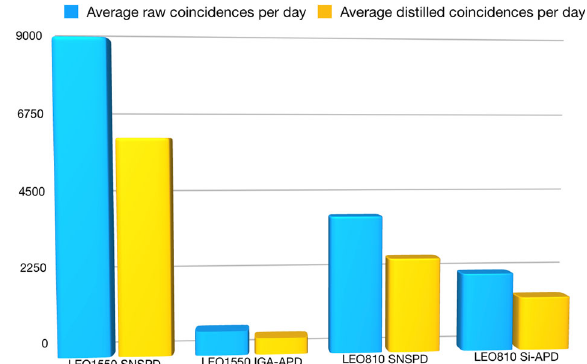
Fig. 7 Mean raw (blue bars) and distilled coincidences per day (orange) as reported in Table 3. Shown are results for the LEO with inclination 50 degrees and height 600 km, and a wavelength of 810 nm and 1550 nm with Avalanche Photo Detectors (Si-APD @ 810 nm, InGaAs-APD @ 1550 nm) and super-conducting nanowire single photon detectors.